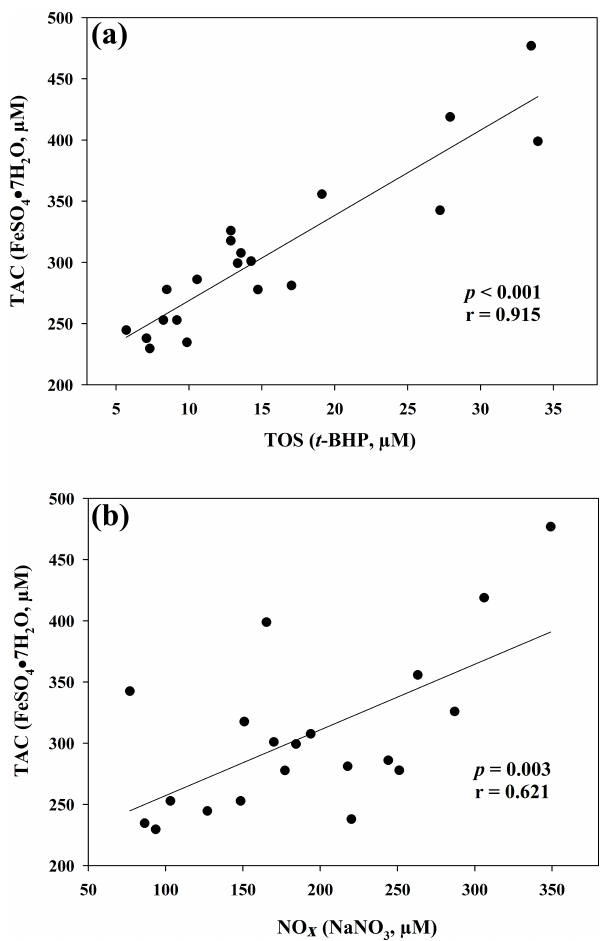
Figure 2. Regression analysis between total antioxidant capacity (TAC) and total oxidant status (TOS) (a) and between total antioxi- dant capacity (TAC) and nitric oxide metabolites (NO x ) (b) in goat kid serum.